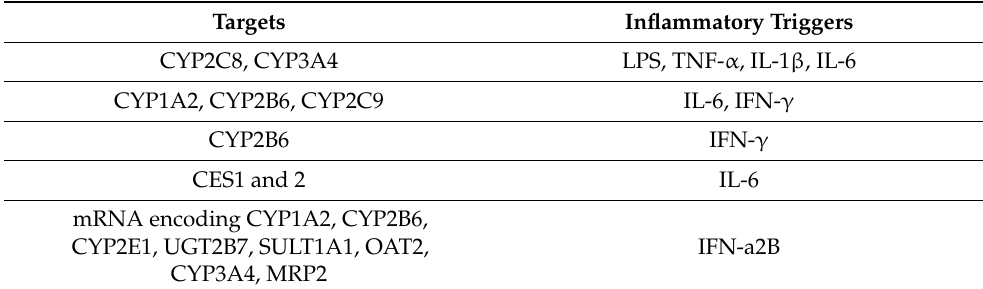
Table 2. Examples of the effect of lipopolysaccharide and pro-inflammatory cytokines on human CYP enzymes CES1 and CES2, phase II enzymes, and drug